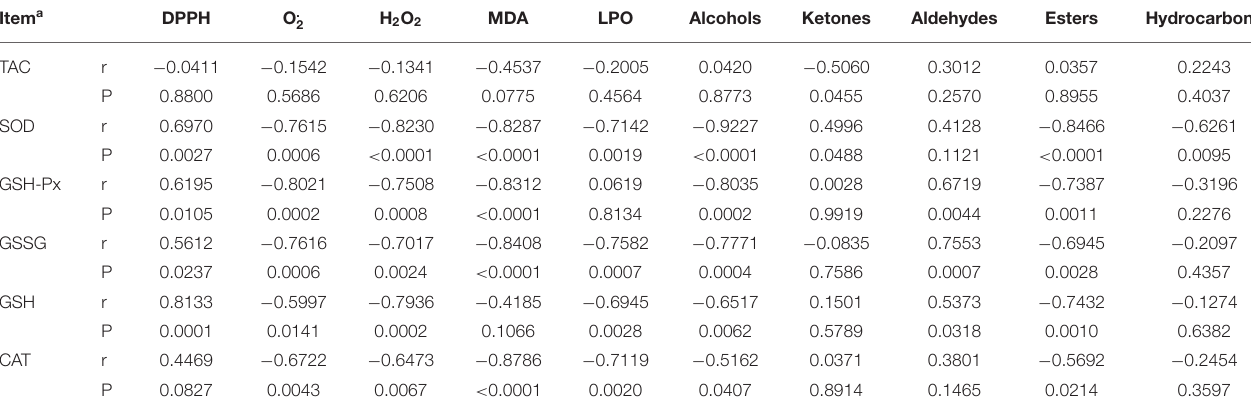
TABLE 5 | Pearson correlation coefficients between antioxidant activity, free radical, lipid peroxidation, and volatile compounds in milk. Item